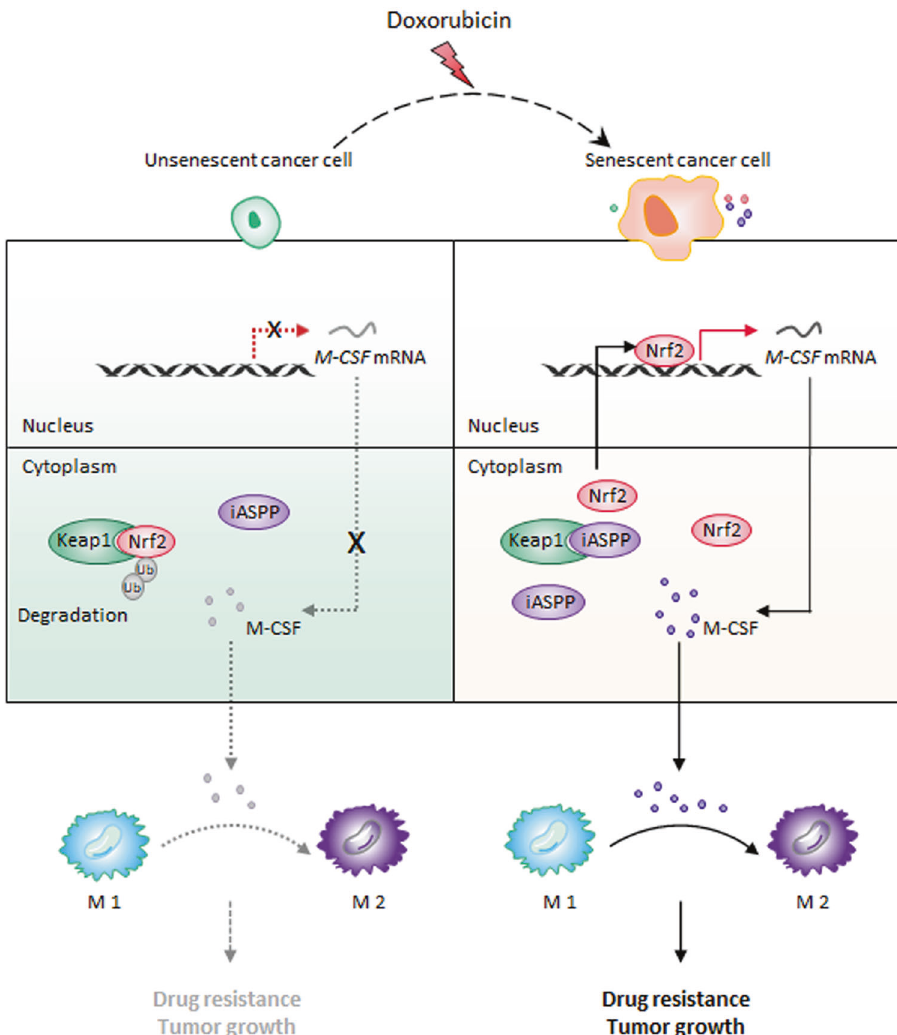
Fig. 8 Schematic working model for the role of iASPP-Nrf2-M-CSF in regulating M2 polarization in the context of chemotherapy-induced senescence. The expression of Nrf2 is increased after triggering senescence in cancer cells. This is due to the parallel enhancement of iASPP. Increased iASPP binds with Keap1 in the cytoplasm, and thereby suppresses Keap1-mediated Nrf2 degradation. The accumulated Nrf2 enters into the nucleus, where it binds to the promoter region of M-CSF gene and transactivates M-CSF expression. M-CSF secretes into the microenvironment and contributes to the iASPP-Nrf2-mediated M2 polarization, resulting in tumor growth and resistance to Dox-mediated anti-tumor